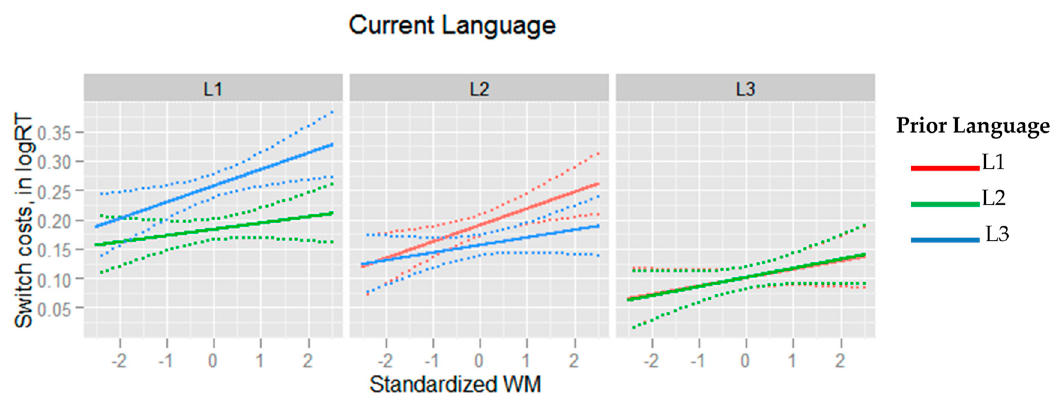
Figure 4. Relationship between working memory and language switch costs (in log RT) by the language on the current trial. A larger standardized working memory (WM) score indicates better working memory updating abilities. Dotted lines indicate 95% confidence bands.